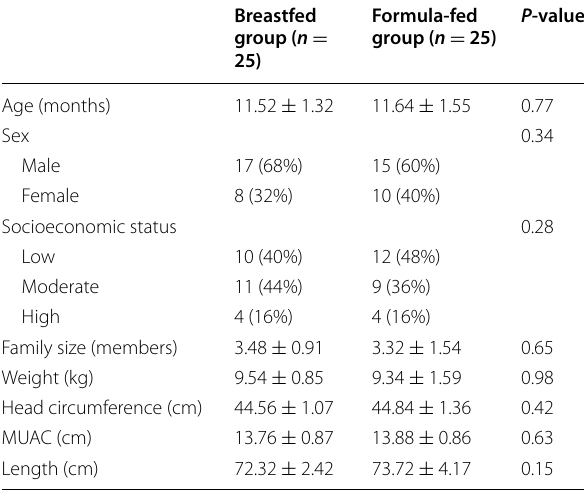
Table 1 Characteristics of studied cases among the enrolled groups